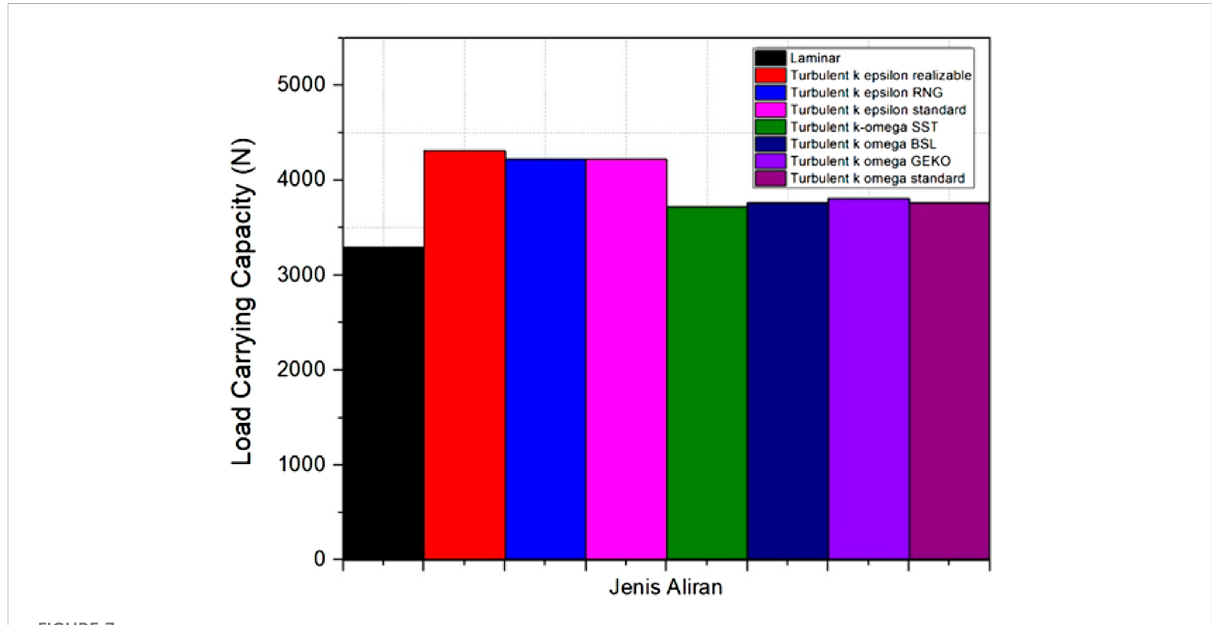
FIGURE 7 Smooth journal bearing dengan, ε = 0.7 dan ω = 3,000 rpm LCC.